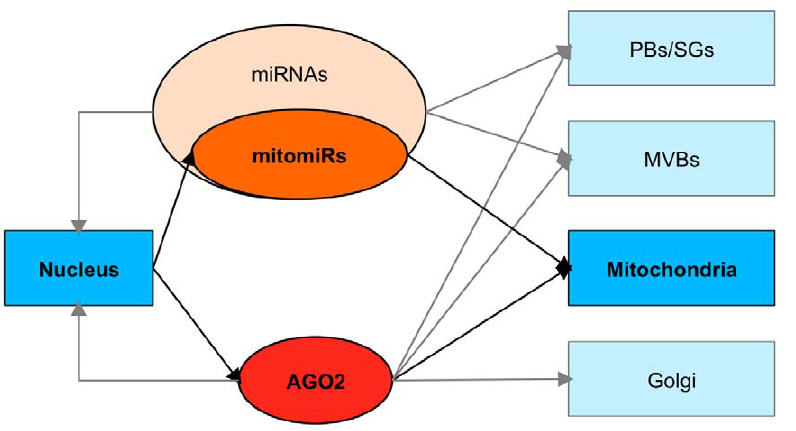
Figure 8. Integrative model for subcellular localization of RNAi components. Boxes represent the subcellular compartments. RNAi components are encircled. Arrows indicate the molecular fluxes documented herein in regards to the mitochondrial miRNAs (mitomiRs), and previously in P-bodies (PBs) [17], stress granules (SGs) [16,54], multivesicular bodies (MVBs) [21] and Golgi [26]. Depending on the localization, different functions are ascribed to AGO2, such as post-transcriptional gene silencing or reversible translational regulation in P-bodies [50] and stress granules [16], and transcriptional regulation in the nucleus [51]. In mitochondria, the presence of mitochondrial genome adds another possible layer of regulation by AGO2.